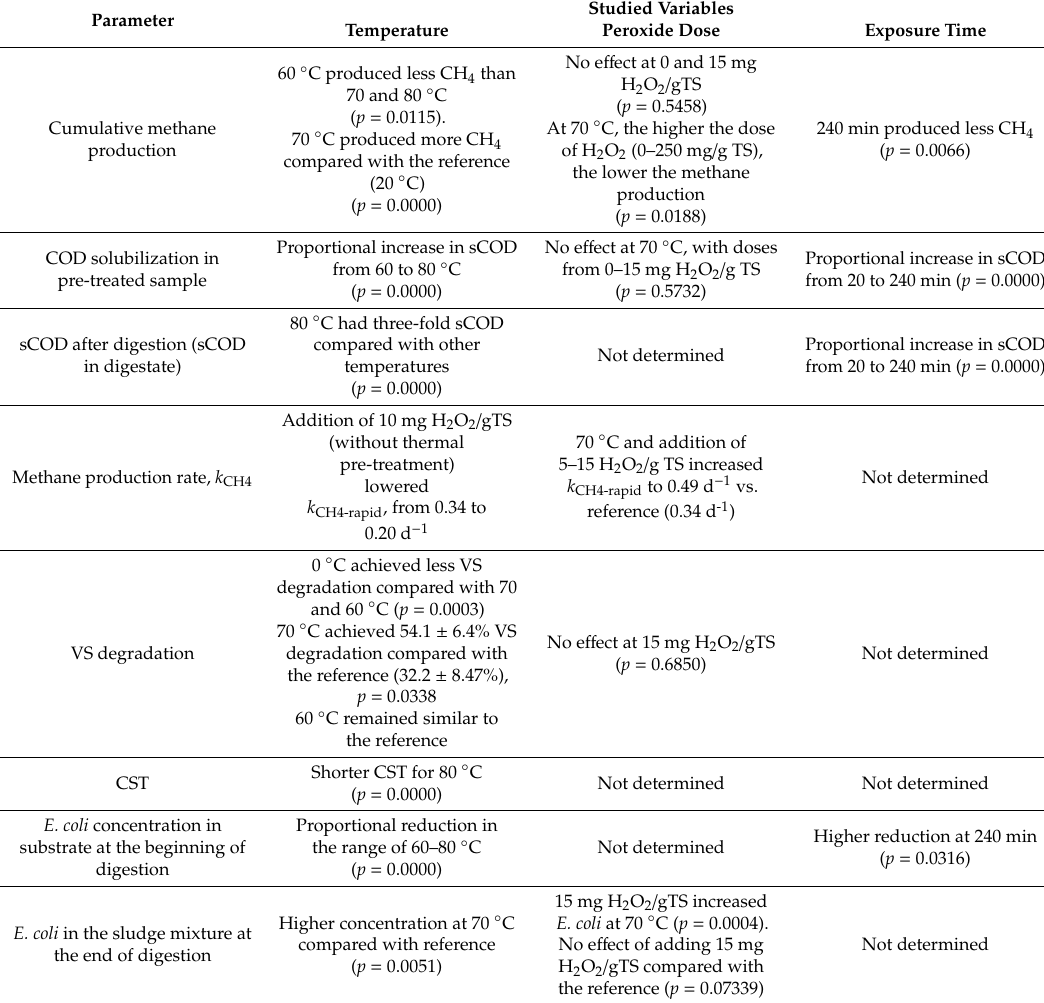
Table 1. E ff ects of the studied variables related to applied temperature, H 2 O 2 dose, and exposure time. CST, capillary suction time; sCOD, soluble fraction chemical oxygen demand; VS, volatile solid; TS, total